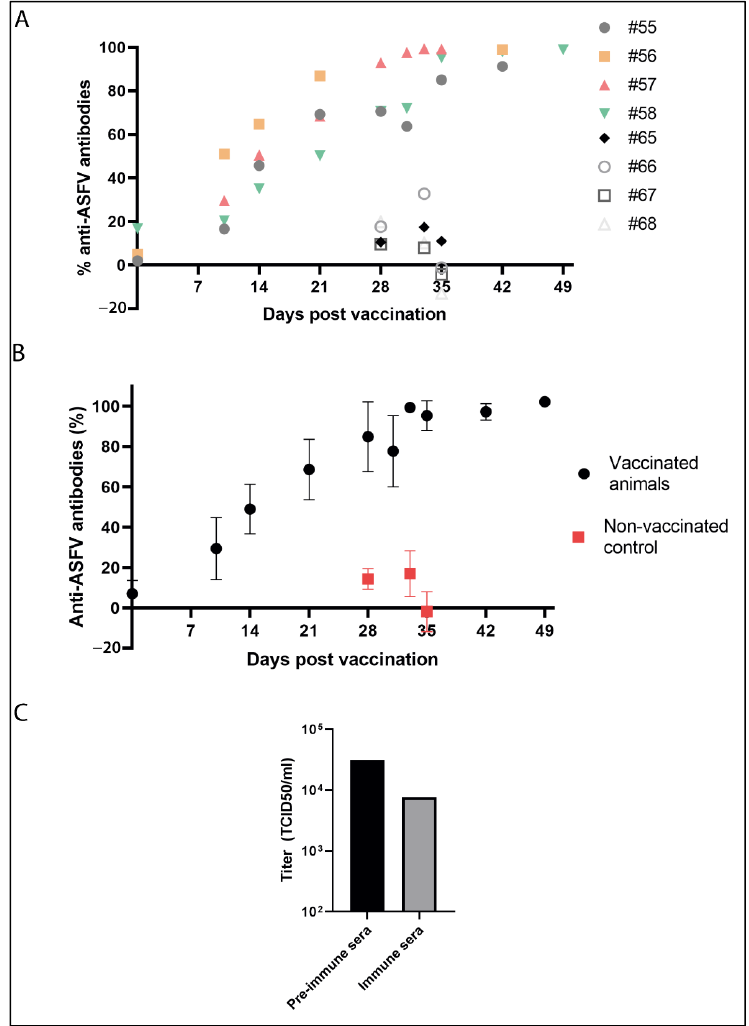
Figure 6. Specific anti-ASFV antibodies detected by ELISA can neutralize ASFV infection. ELISA (“ELISA INgezim PPA COMPAC” (Ingenasa), which uses p72 as viral protein) was used to quantify specific antibodies against ASFV in sera of individual ( A ) or mean ( B ) of vaccinated (#55-58) and non-vaccinated (#65-68) animals after vaccination. Challenge was inoculated at 28 dpv. More than 50% in considered positive for the presence of anti-ASFV antibodies. ( C ) Anti-ASFV antibodies par- tially neutralize ASFV infection. Arm- Δ CD2v- Δ A238L was preincubated with pre-immune or im- mune sera (28 dpv) and then used to infect COS cells. A number of 72 hpi supernatant containing virus was harvested and titrated in COS cells.